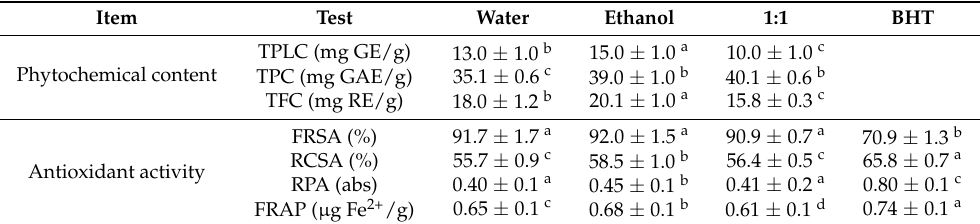
Table 1. Phytochemical content and antioxidant activity of POP